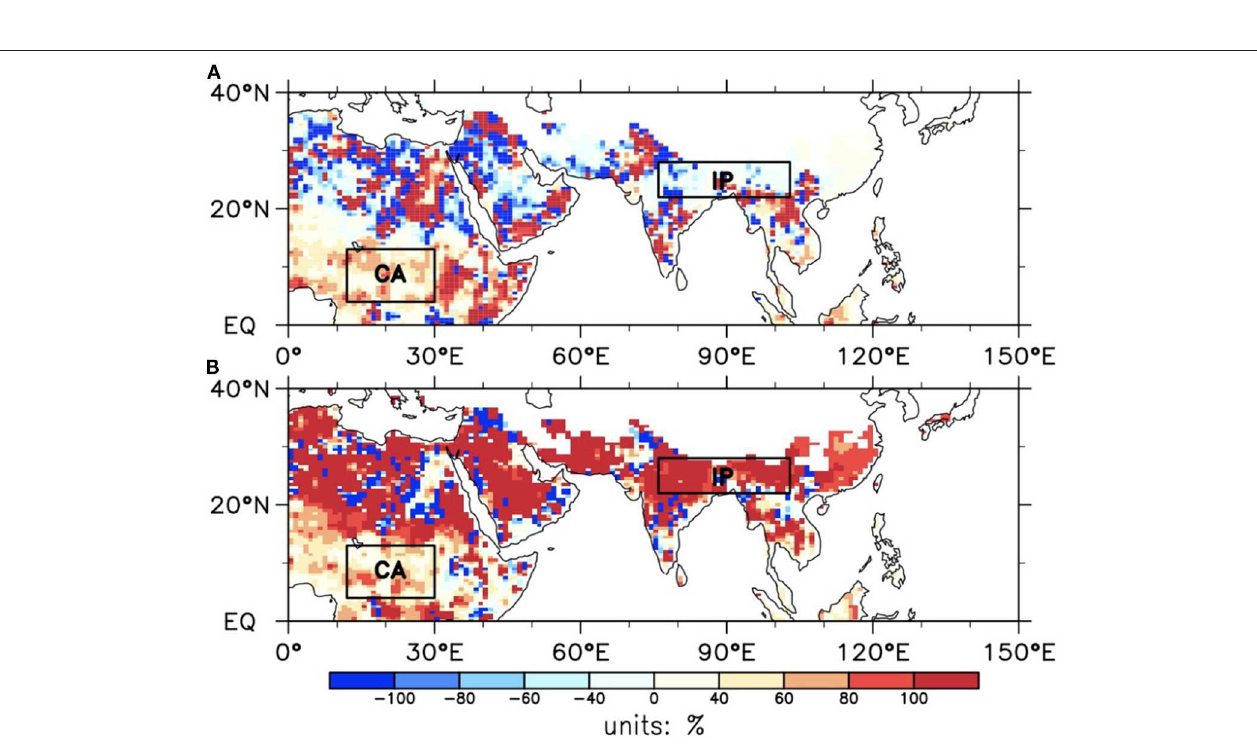
FIGURE 9 | The relative contributions of (A) soil liquid water and (B) soil temperature to soil enthalpy trends at mid-low latitudes.